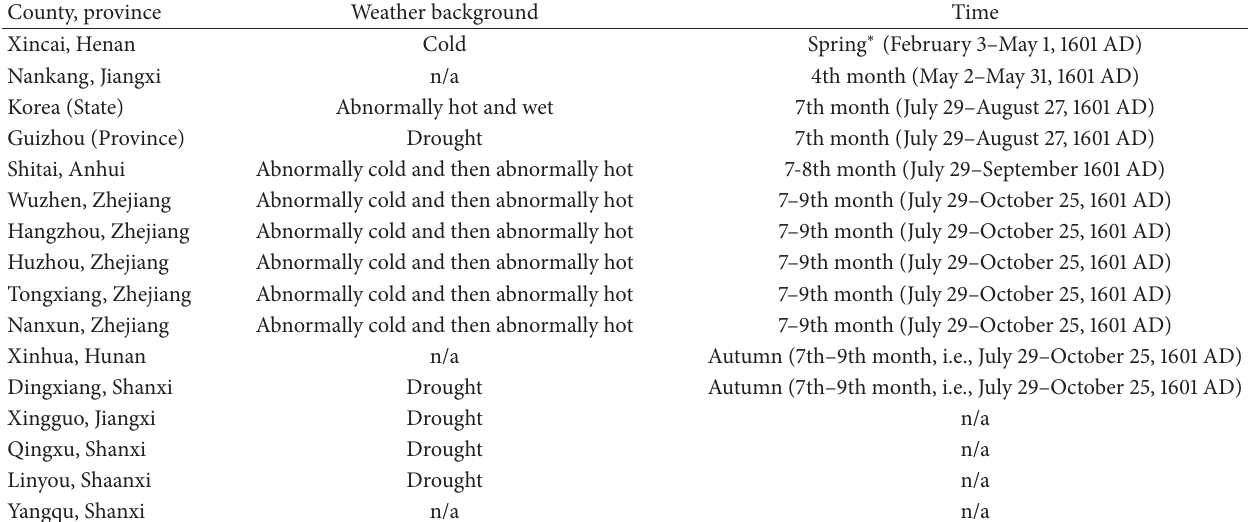
Table 4: Temporal distribution and weather background of the epidemics in China and Korea in 1601 AD. County,